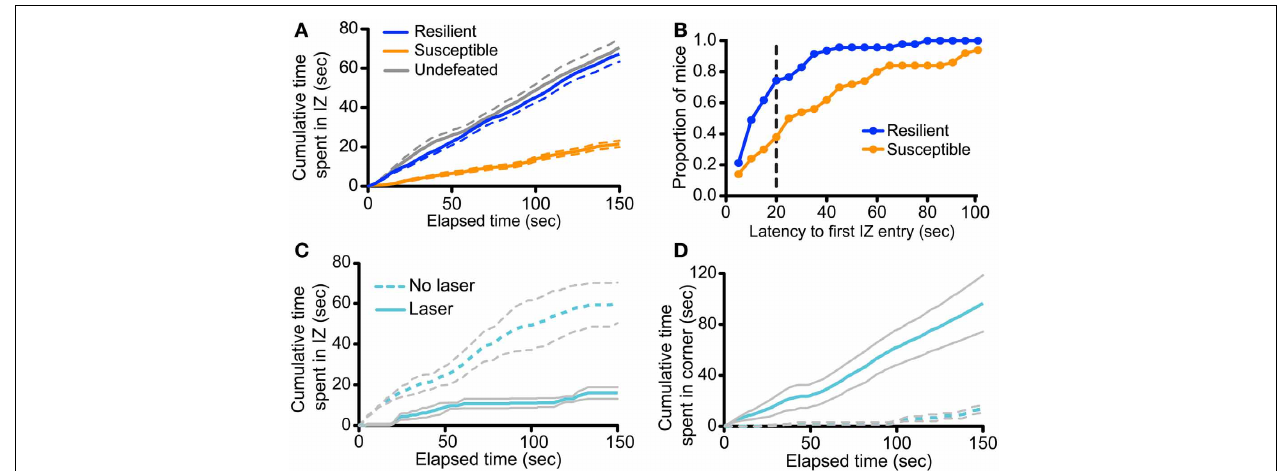
FIGURE 7 | Defeat and photoactivation of vmPFC terminals in the DRN bias social approach/avoidance choices. (A) Analysis was performed on 97 previously defeated and 20 undefeated mice. Defeated mice were characterized as resilient or susceptible based on previously described criteria (Golden et al., 2011; Challis et al., 2013). The cumulative time spent in the interaction zone (IZ) was plotted across the duration of the social interaction test. The cumulative interaction time of susceptible mice significantly diverged from that of both resilient and control mice at 4s (Repeated measures ANOVA, Fisher post-hoc , p = 0 . 020 at 4s). Data shown is average per group. Dashed lines represent the s.e.m. (B) Latencies to the first IZ entry were determined in 5-s bins. Plotted are the proportions of mice within each behavioral group to display first IZ entry within the given timeframe or less. A greater proportion of resilient mice first entered the IZ faster that of